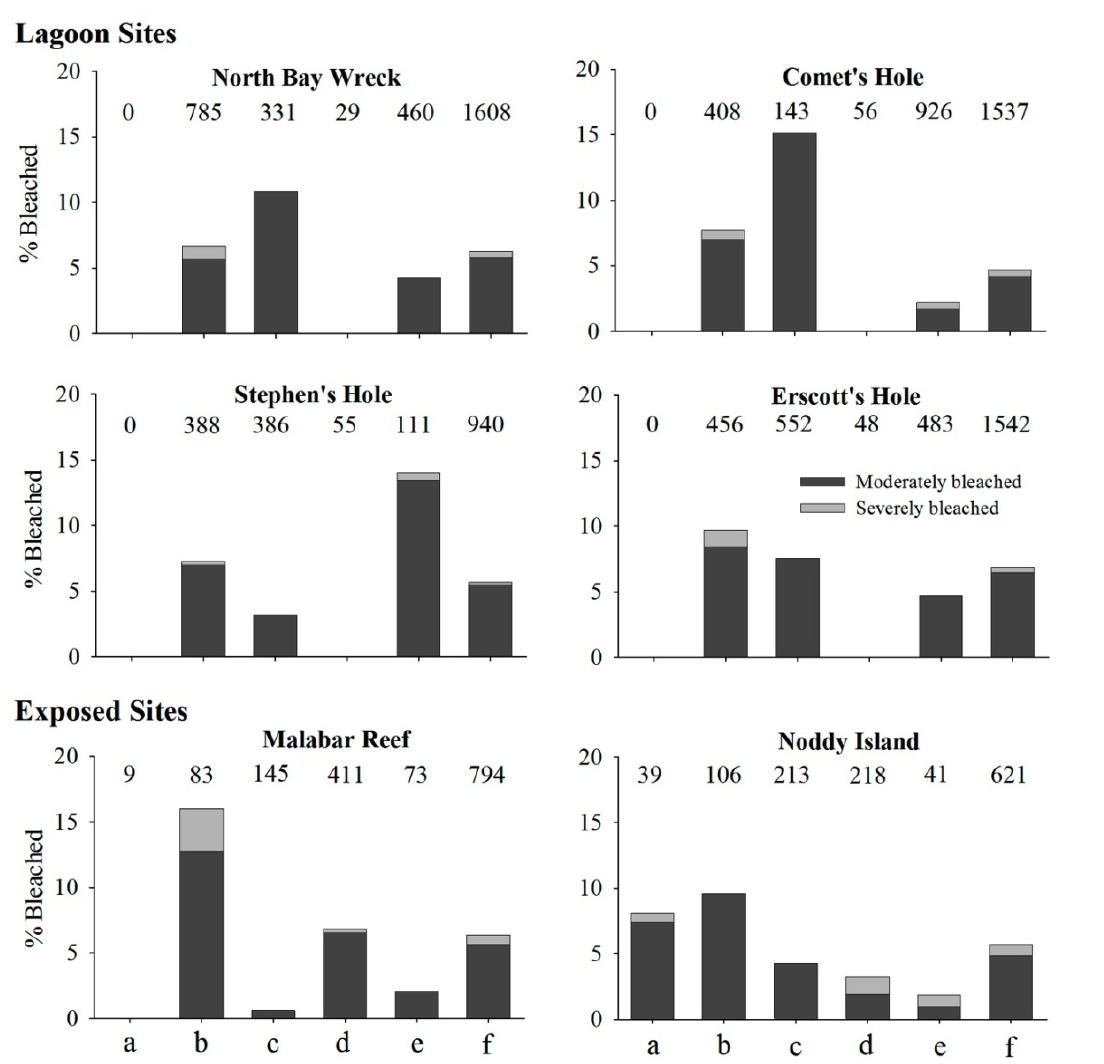
Figure 4. Average proportion of bleaching response (moderate-dark grey and severe-light grey) for different families at reefs adjacent to Lord Howe Island recorded in May